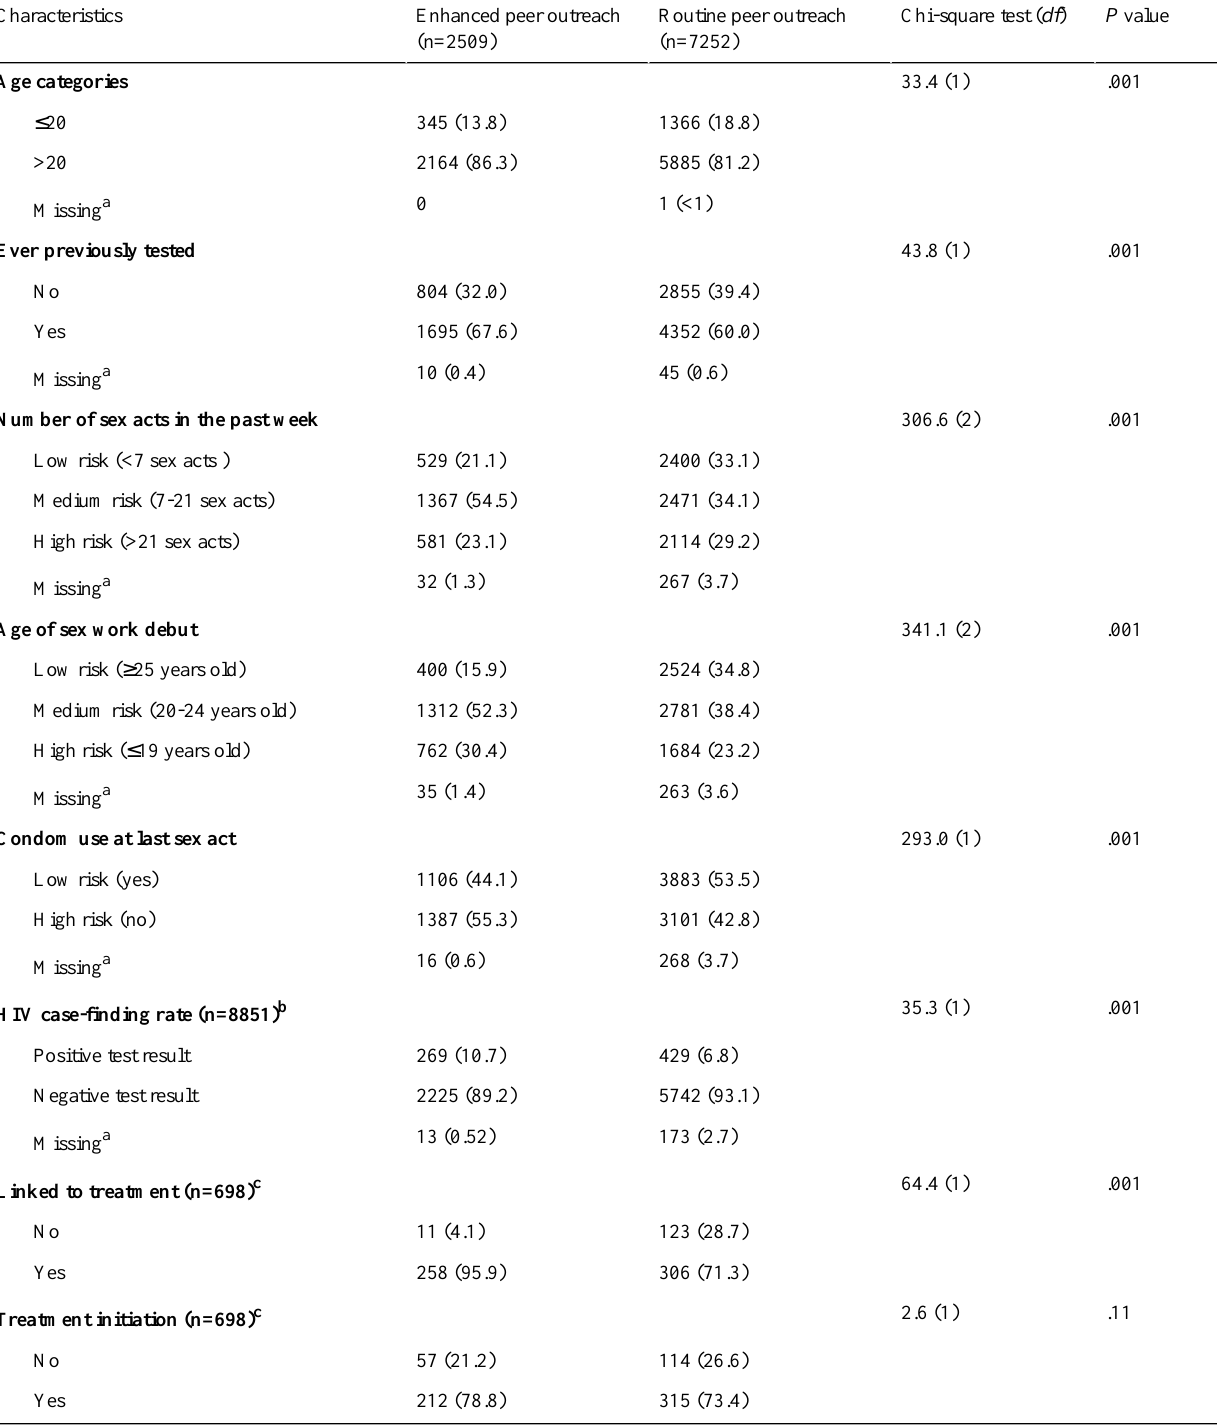
Table 4. Comparison of age and other HIV-related indicators by outreach